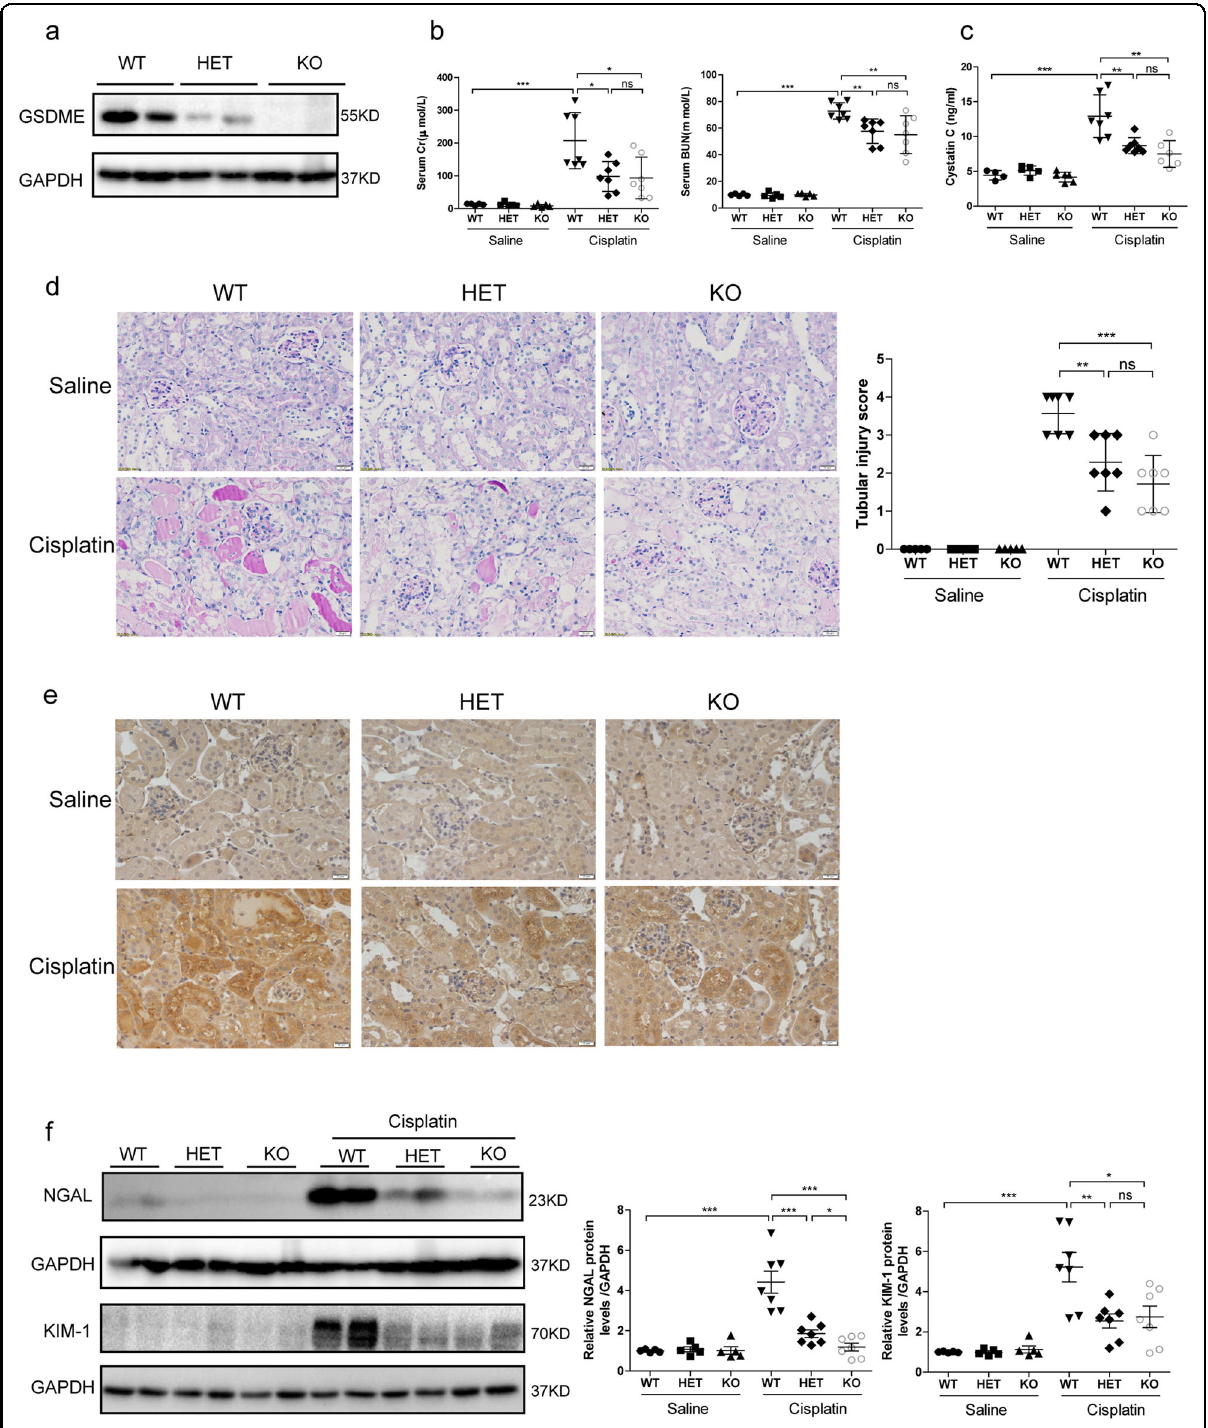
Fig. 2 GSDME deletion attenuated cisplatin-induced renal function loss and pathological injury. WT, HET, and KO mice (12 weeks) were subjected to 25 mg/kg of cisplatin or the same volume of saline (Saline group, n = 5; Cisplatin group, n = 7). a Expression of GSDME in mouse kidneys by immunoblotting ( n = 2). b , c Serum Cr, BUN, and Cystatin C levels of mice. d PAS staining and the associated renal tubular injury score analysis (scale bar = 20 μ m). e Renal protein level of NGAL in kidney tissues, as detected by immunohistochemistry (scale bar = 20 μ m). f Immunoblotting of NGAL and KIM-1 in kidney tissues. * P < 0.05, ** P < 0.01, and *** P <